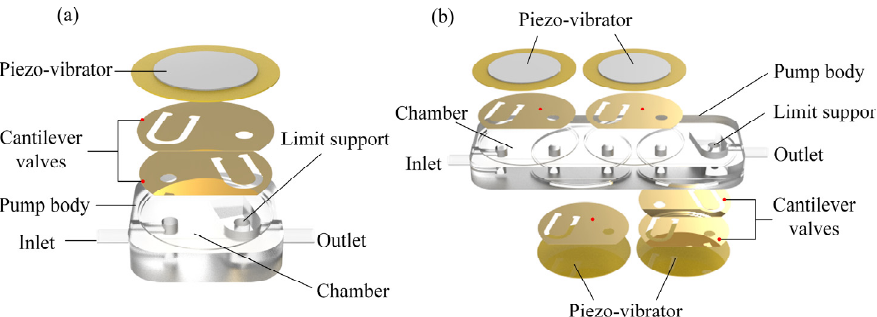
Figure 1. Exploded diagram of single-chamber and four-chamber series piezoelectric micropump. ( a ) Exploded diagram of single-chamber micropump. ( b ) Exploded diagram of four-chamber micropump